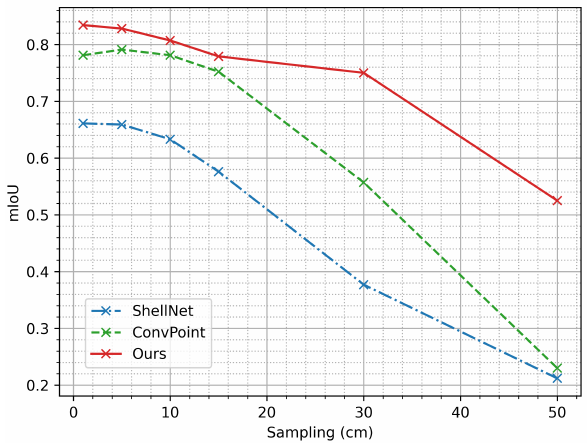
Figure 8. Effect of different grid-sampling resolutions with the Paris-Lyon inference split on the segmentation mIoU metric. The tested resolutions are 1cm, 5cm, 15cm, 30cm,